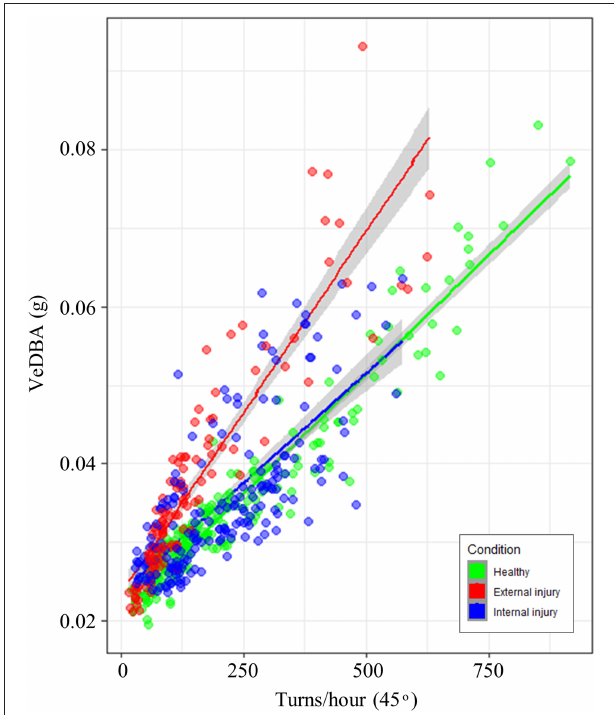
FIGURE 1 | Relationship between the number of turns per hour that surpassed a 45 ◦ threshold and mean VeDBA (g) per hour. Data points and regression lines are colored according to turtle condition (healthy = green, external injury = red and internal injury = blue); 95% confidence intervals are indicated by the gray shading either side of regression lines. Line gradients indicate that the relationship between turning rate and VeDBA differed little between healthy turtles and those with internal injuries; turtles with external injuries however, had substantially higher VeDBA values per number of